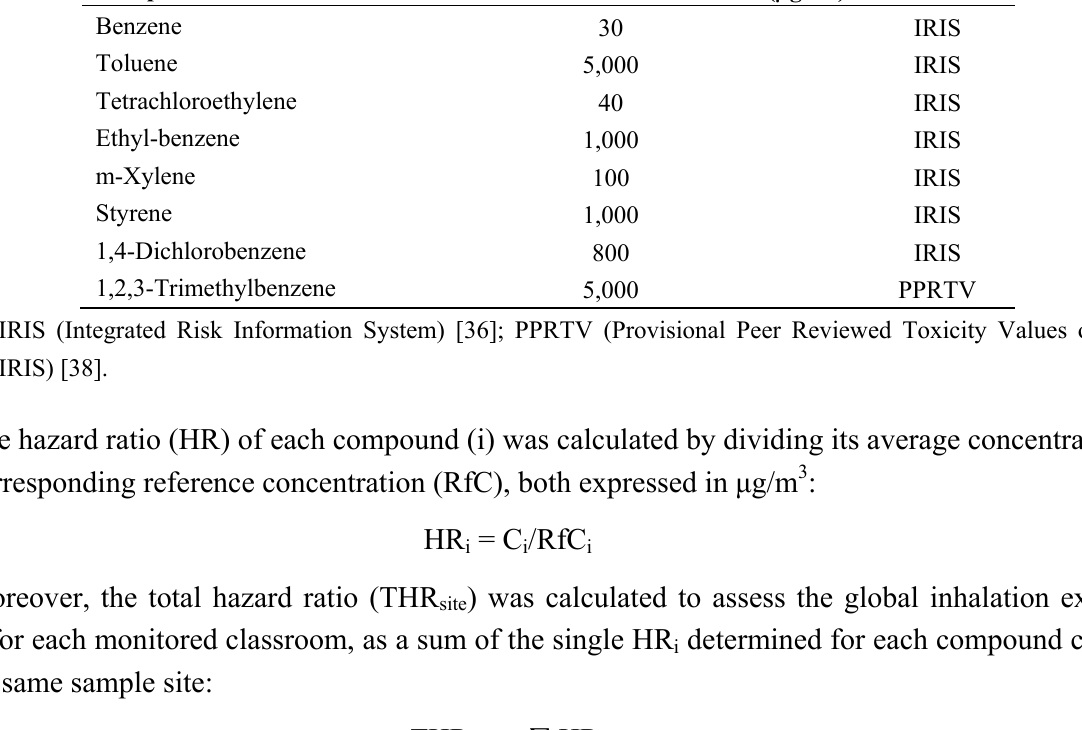
Table 3. Non-cancer reference concentrations (µg/m 3 ) of the VOCs found during the monitoring campaign. Compound REFERENCE CONCENTRATION (µg/m 3 ) SOURCE Benzene 30 IRIS Toluene 5,000 IRIS Tetrachloroethylene 40 IRIS Ethyl-benzene 1,000 IRIS m-Xylene 100 IRIS Styrene 1,000 IRIS 1,4-Dichlorobenzene 800 IRIS 1,2,3-Trimethylbenzene 5,000